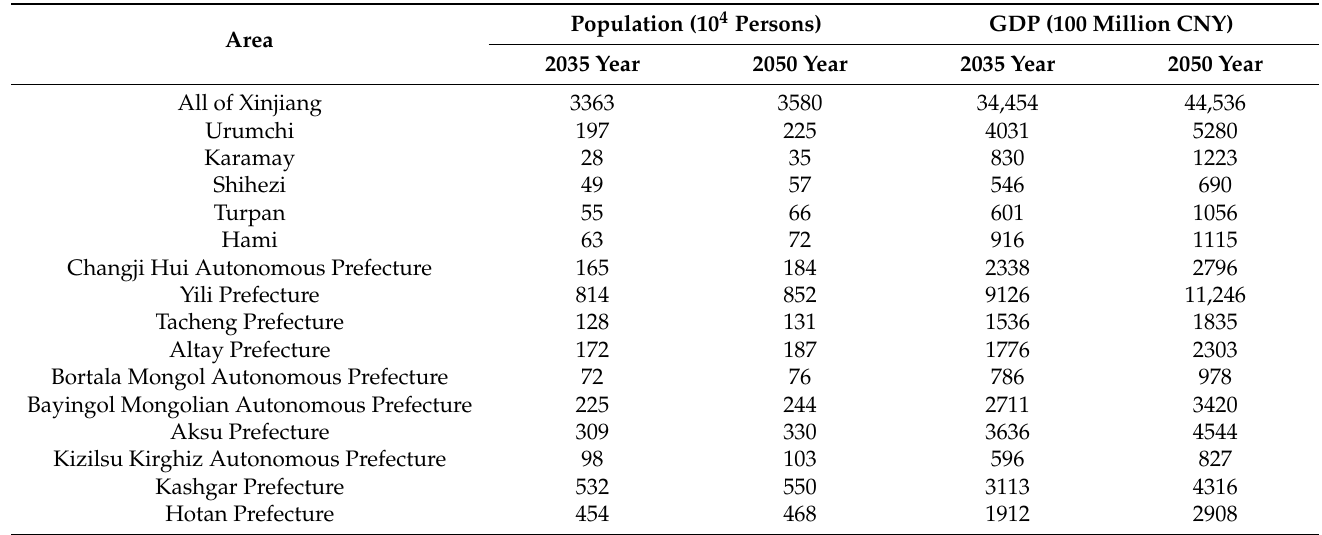
Table 3. The predicted population and economic scale that can be carried by water resources in Xinjiang in two planning-level